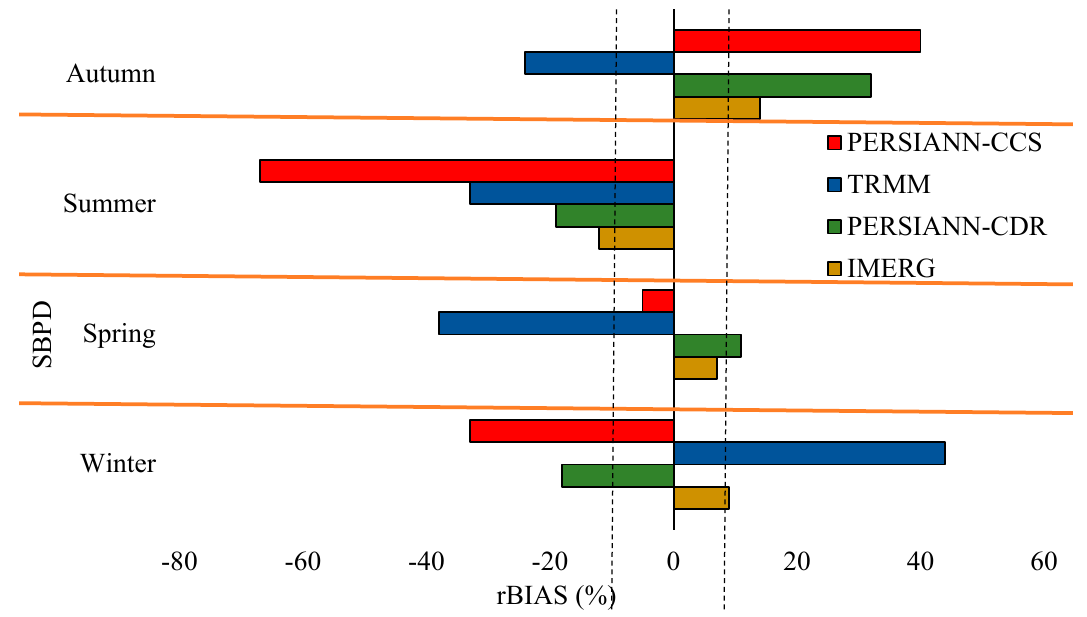
Figure 18. Seasonal performance of all SBPD.